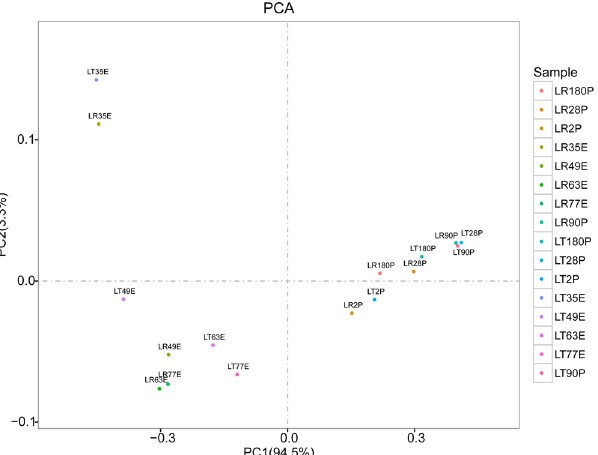
Figure 1. Category DE-miRNA expression pattern. PCA analysis of DE-miRNAs. The analyses were based on the normalized expression data for DE miRNAs in 8 libraries. The clustering of miRNAs into the pre- and post-natal stages can be clearly observed in the graph. E represents embryonic stages and P represents postnatal